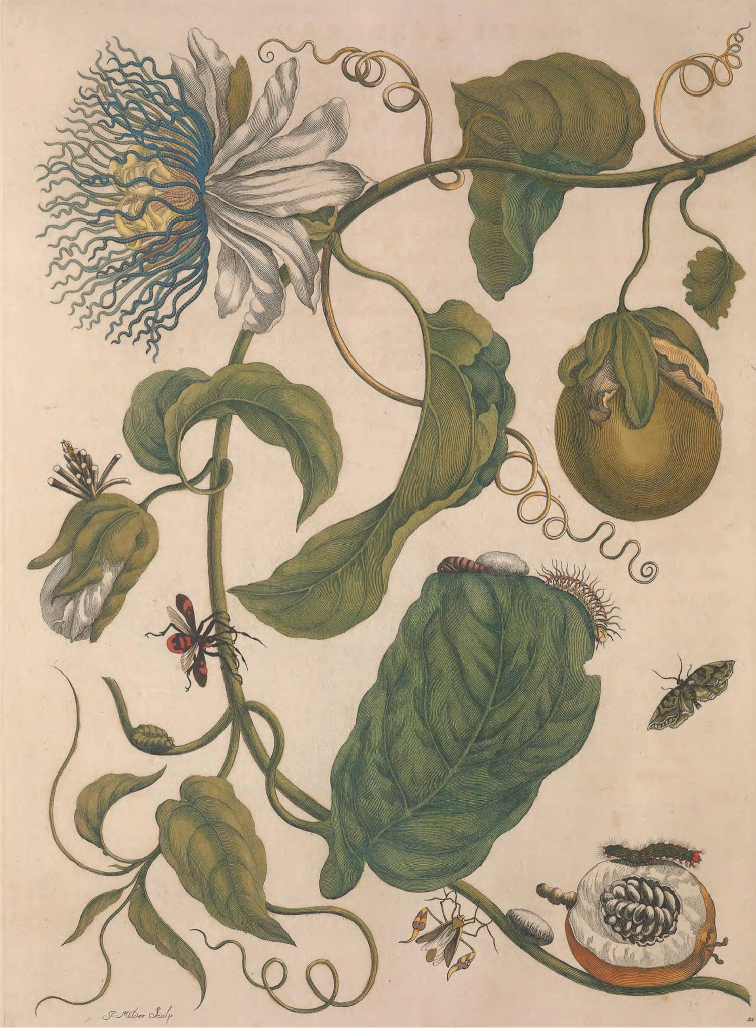
Illustration of the ‘marquiaas’ in “Metamorphosis Insectorum Surinamensium” by Merian (1705).